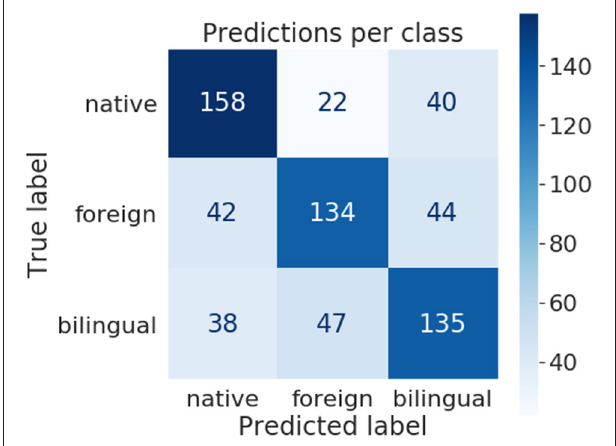
FIGURE 1 | Confusion matrix of multiclass model predictions based on set of text